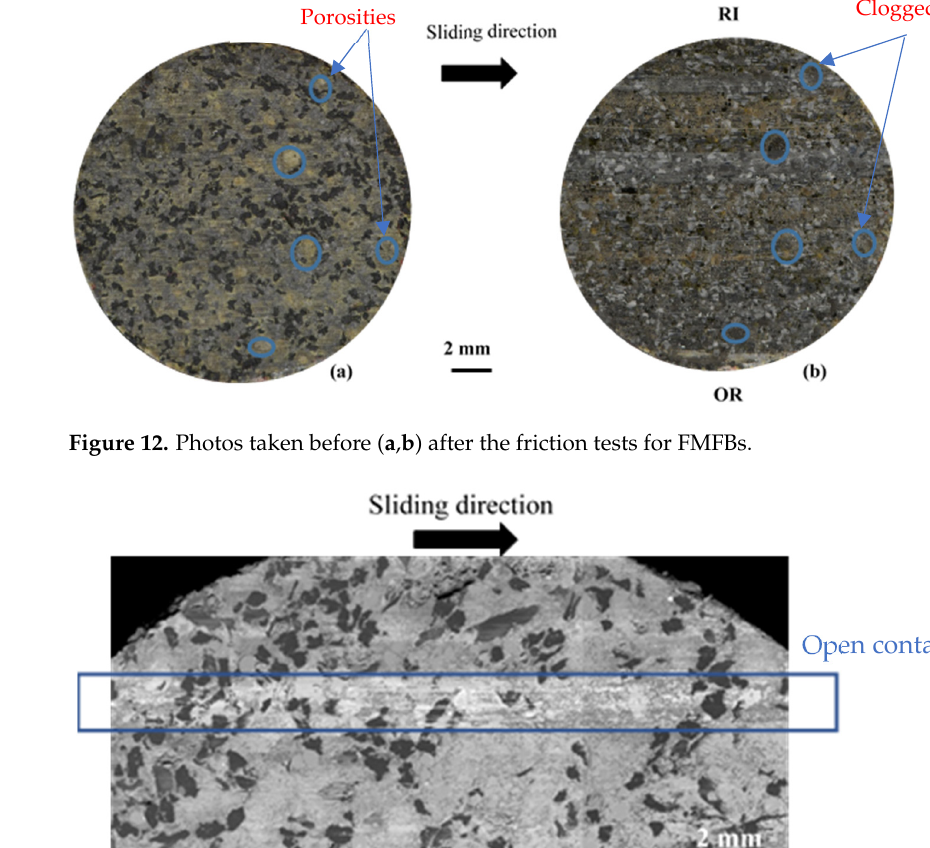
Figure 13. Open contact area at the IR (SEM and BSE).